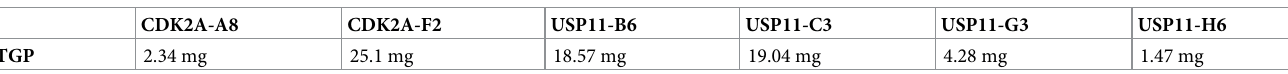
Table 5. Purified scTGP proteins obtained from 1litre protein expression